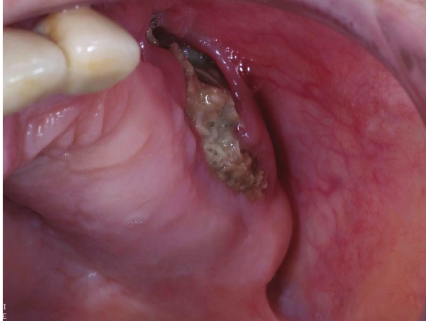
Figure 2: Exposed necrotic bone after tooth extractions in a patient treated with i.v. zoledronic